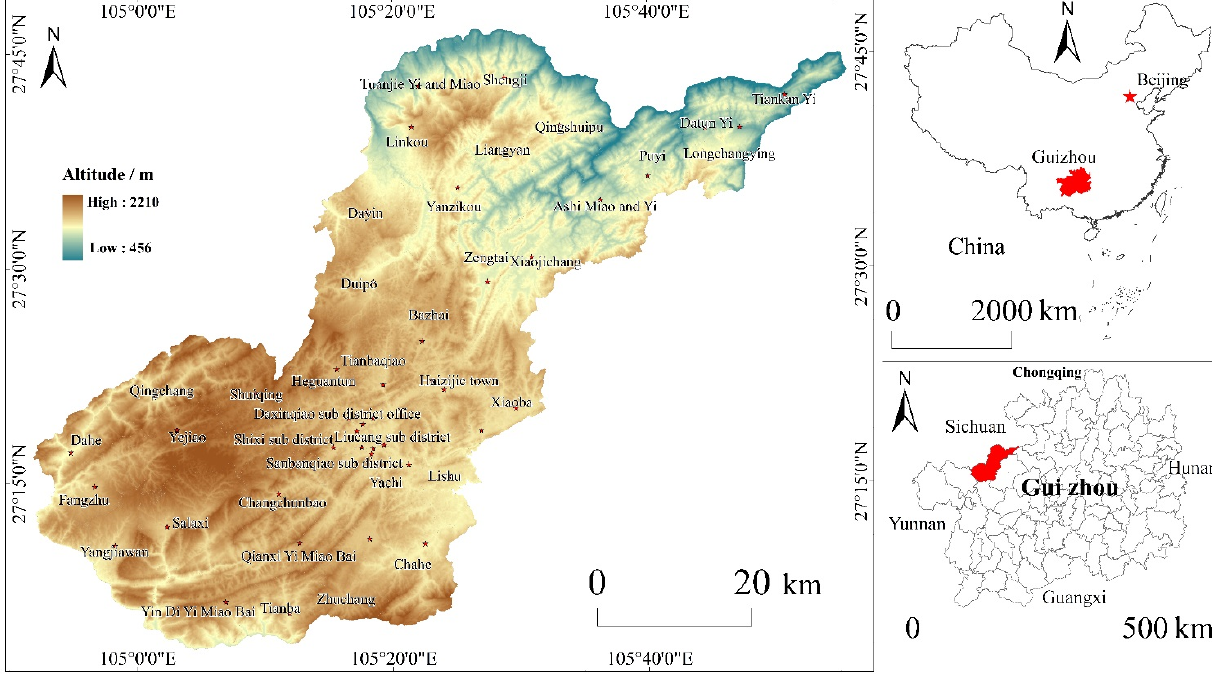
Figure 1. Topographic and location map of study area.